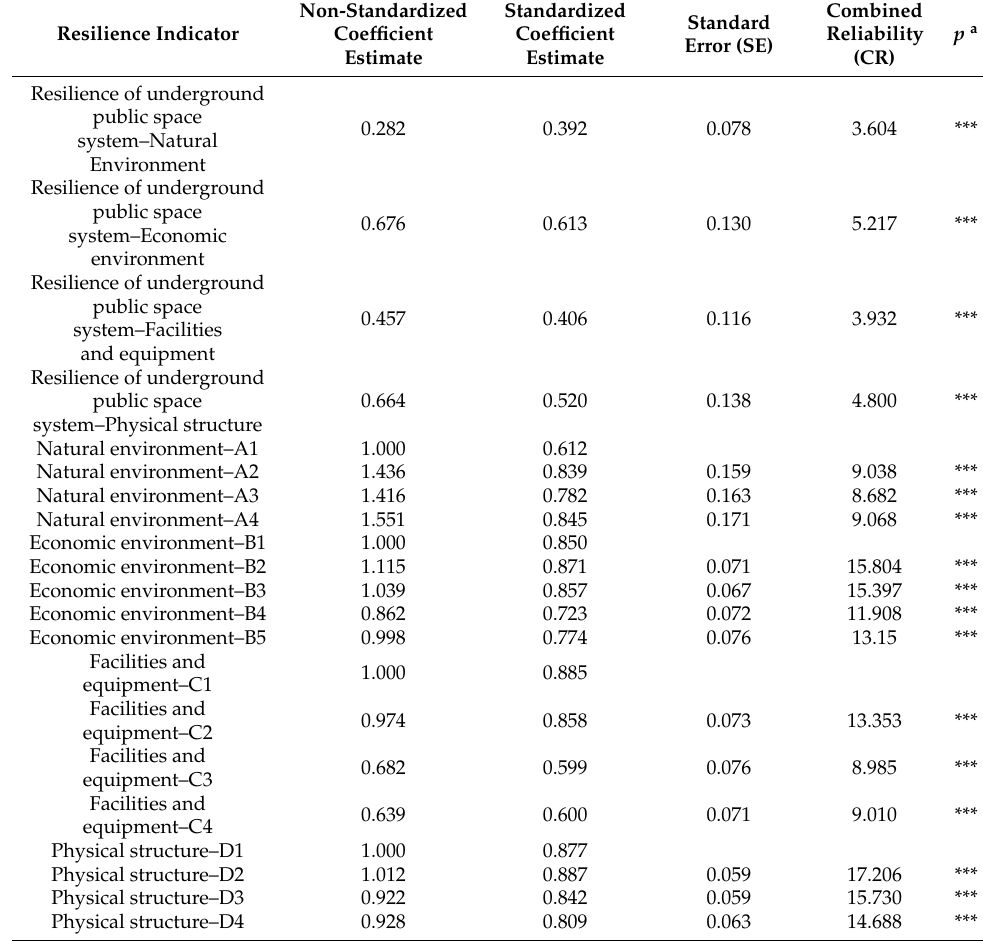
Table 12. Parameter estimates and fitness test of the second-order structural equation model.